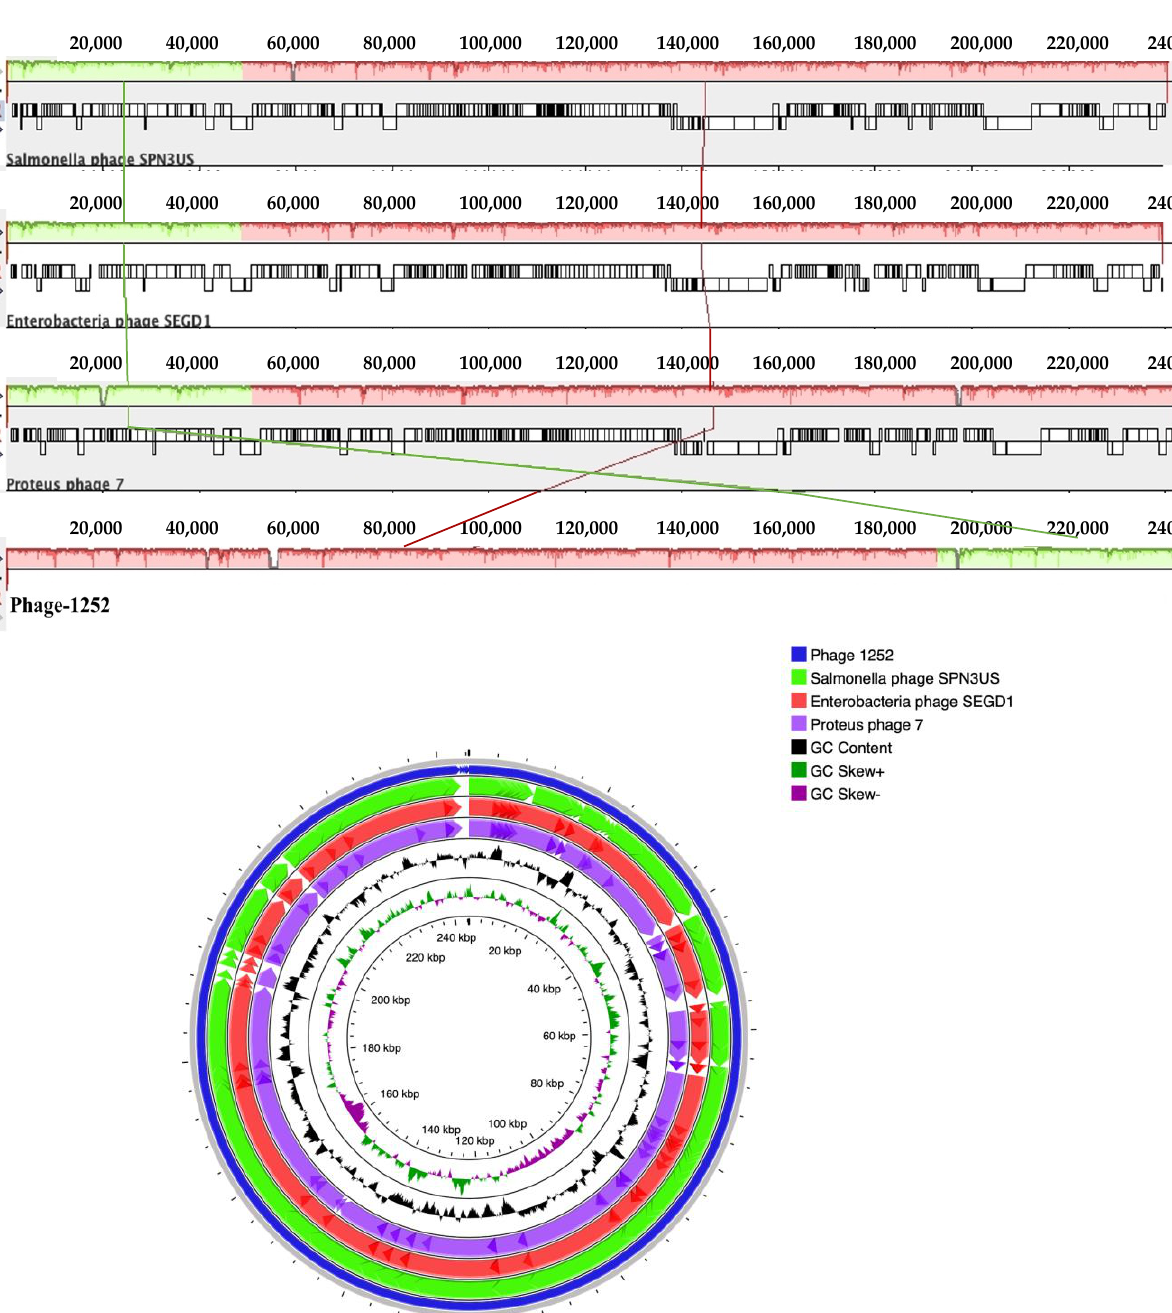
Figure 1. ( a ): Mauve alignment of the annotated complete genomes of phage-1252 with Proteus phage 7, Enterobacteria phage SEGD1, and Salmonella phage SPN3US (from bottom to top). Colored blocks correspond to similarity plots which indicate the degree of sequence similarity between distinct phages, while the height of the plot corresponds to the average nucleotide identity. Sections lacking homology are shown in white inside or outside the blocks. ( b ): Circular map of the phage-1252 genome using CGview. Outer ring (blue) corresponds to the phage-1252 genome. Subsequent rings compare Salmonella phage SPN3US (green), Enterobacteria phage SEGD1 (red), and Proteus phage 7 (purple). The innermost ring shows GC content and GC skew, in which outward peaks correspond to the positive and inward peaks correspond to the